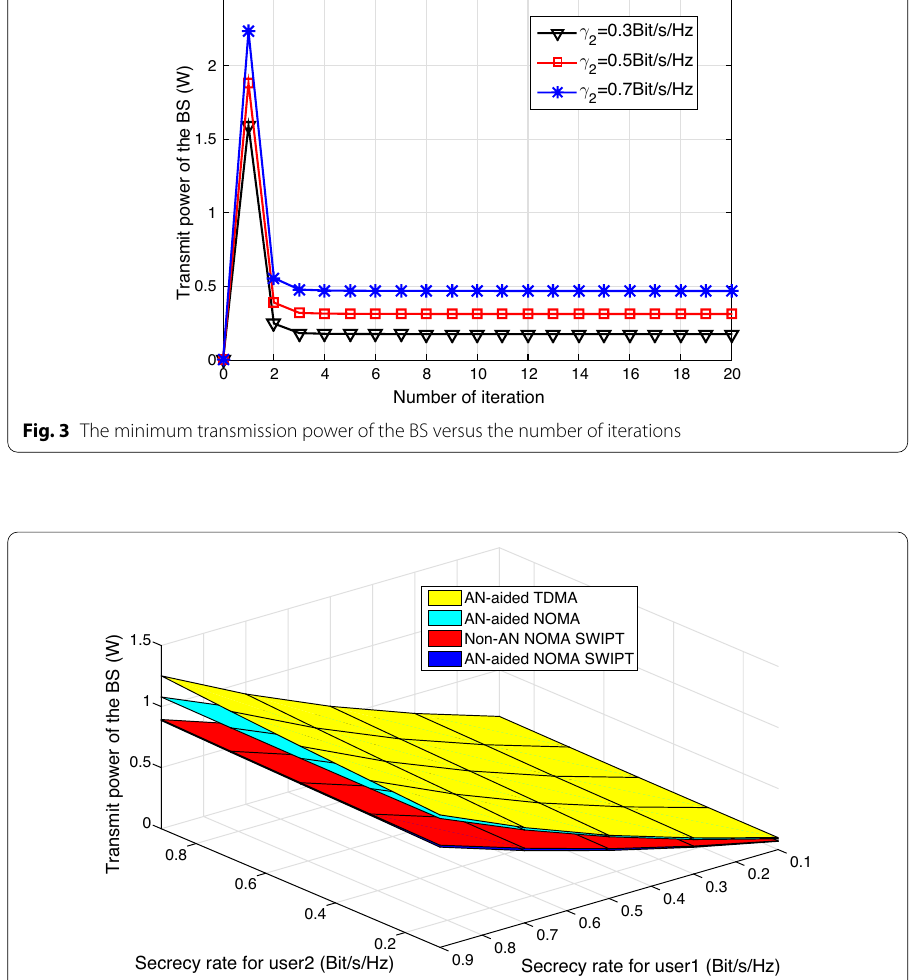
Figure 3 describes minimum transmission power of the BS with respect to the number iterations of the proposed algorithm. The minimum required secrecy rate of user 1 is set to be 0.5 Bits/s/Hz. The minimum required secrecy rate of user 2 is set to be 0.3 Bits/s/ Hz, 0.5 Bits/s/Hz or 0.7 Bits/s/Hz, respectively. It can be found that only few iterations are required to achieve the minimum transmission power of the BS in all case, which indicates that the proposed algorithm is effective.